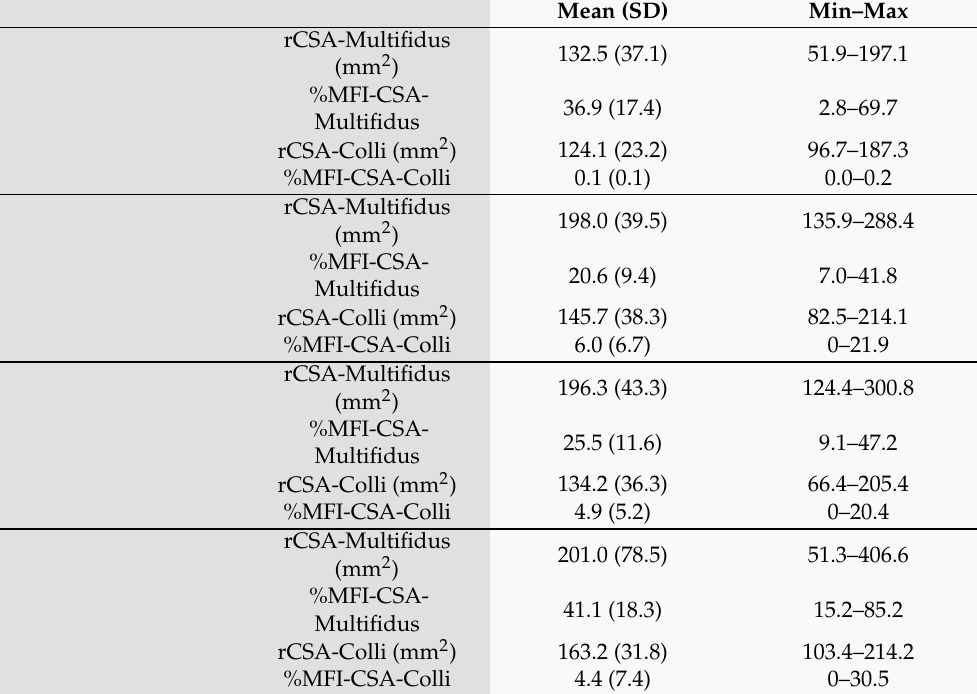
Table 3. MRI measures of the neck muscles’ cross-sectional areas.